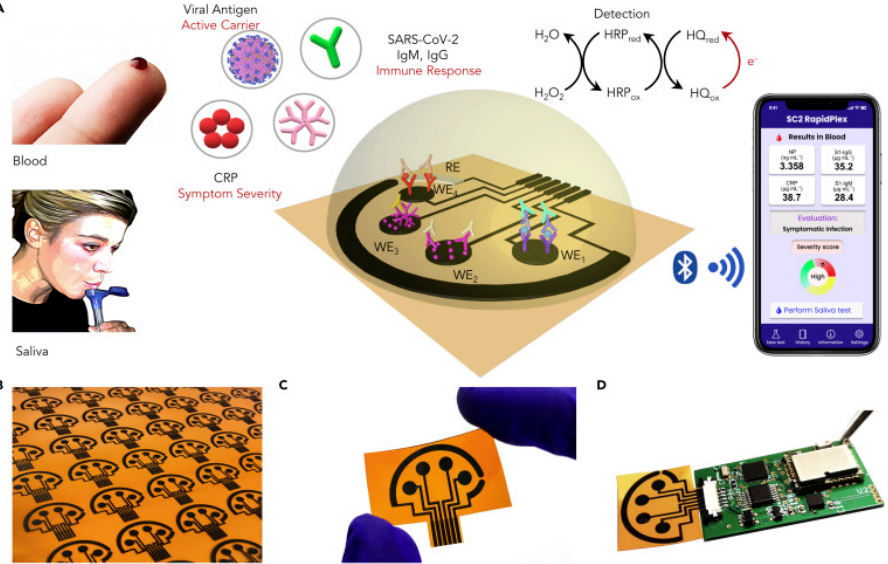
shown in Figure 8.